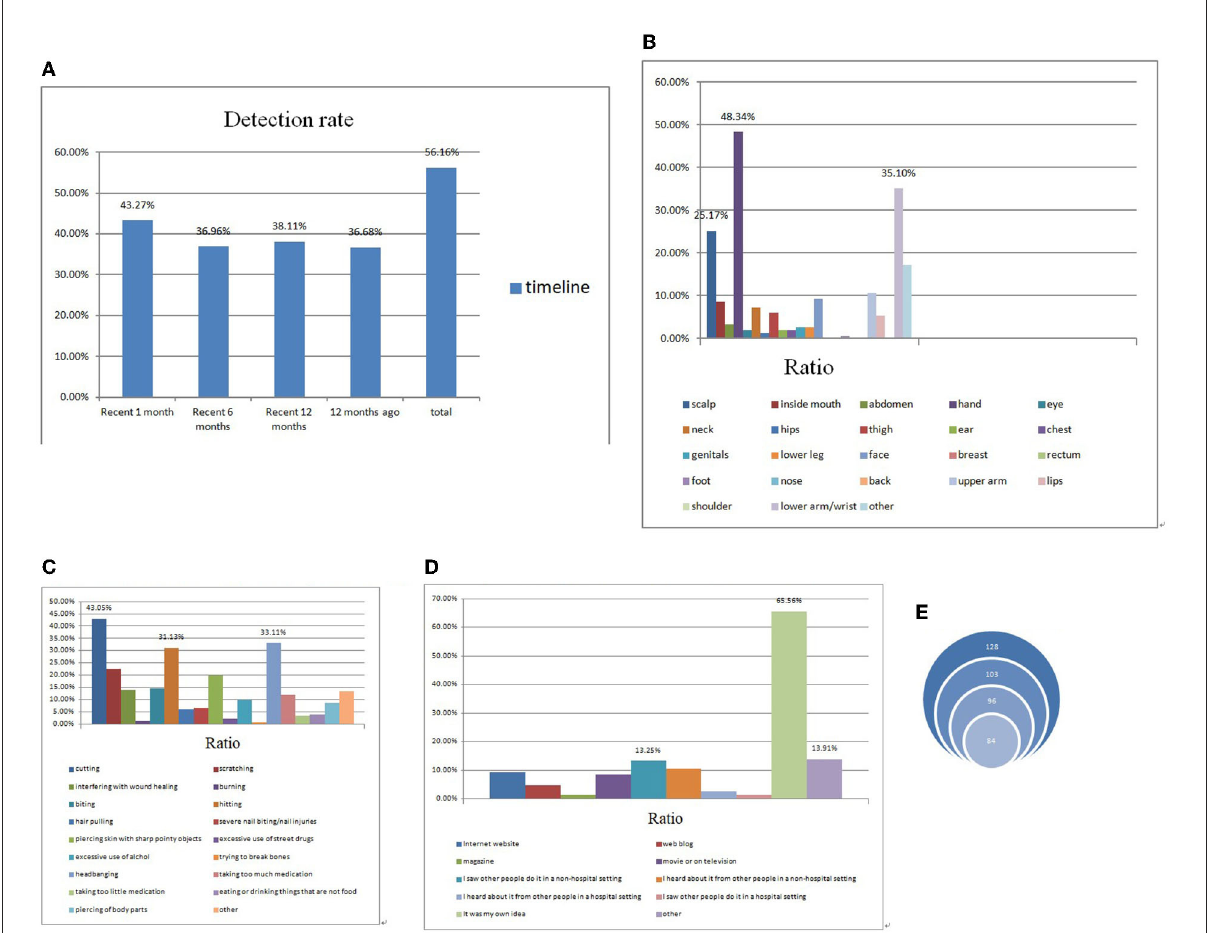
FIGURE2 (A) Detection rate of non-suicidal self-injury (NSSI) among selected subjects. (B) Most hurt areas of NSSI among selected subjects. (C) Most adopted methods of NSSI among selected subjects. (D) Origins of NSSI idea among selected subjects. (E) Repetitive NSSI behaviors among selected